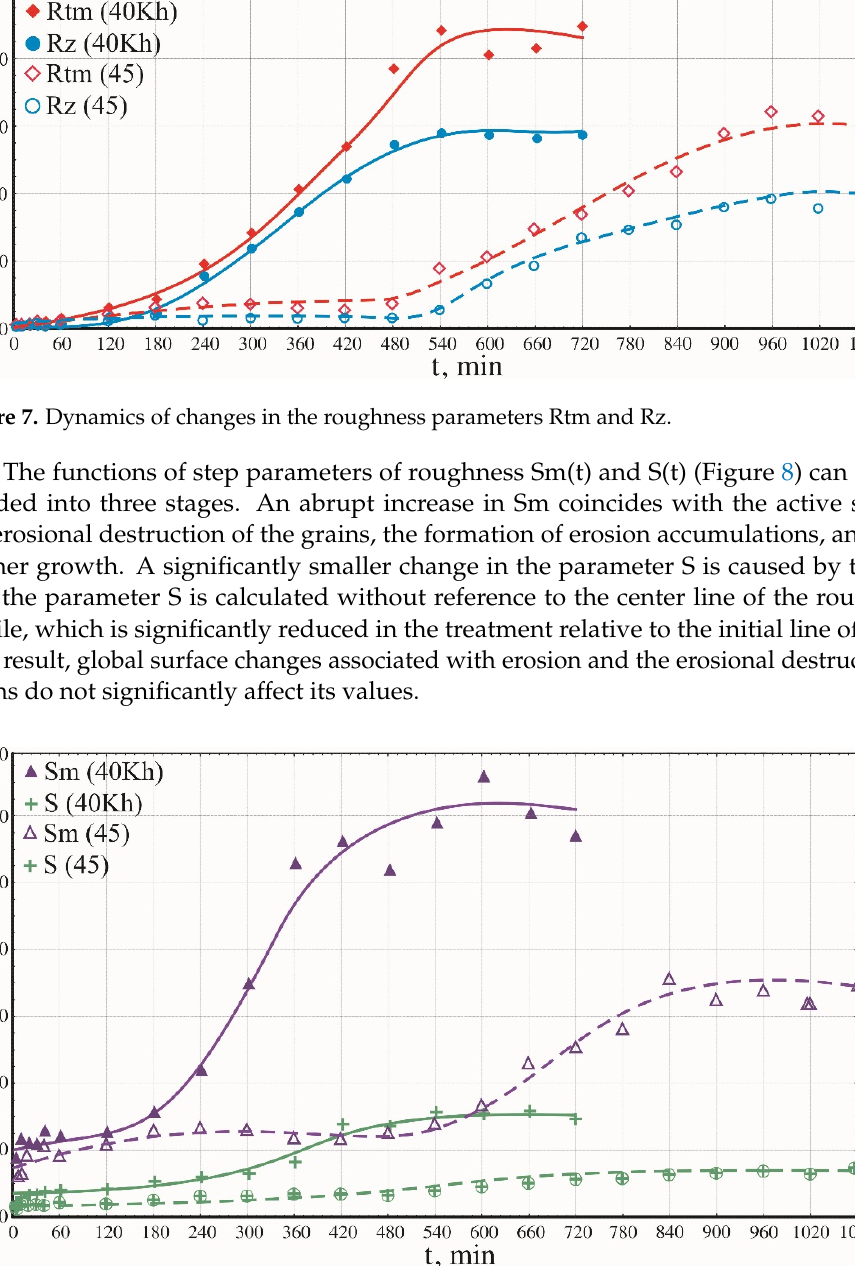
Figure 8. Dynamics of changes in the roughness parameters Sm and S.